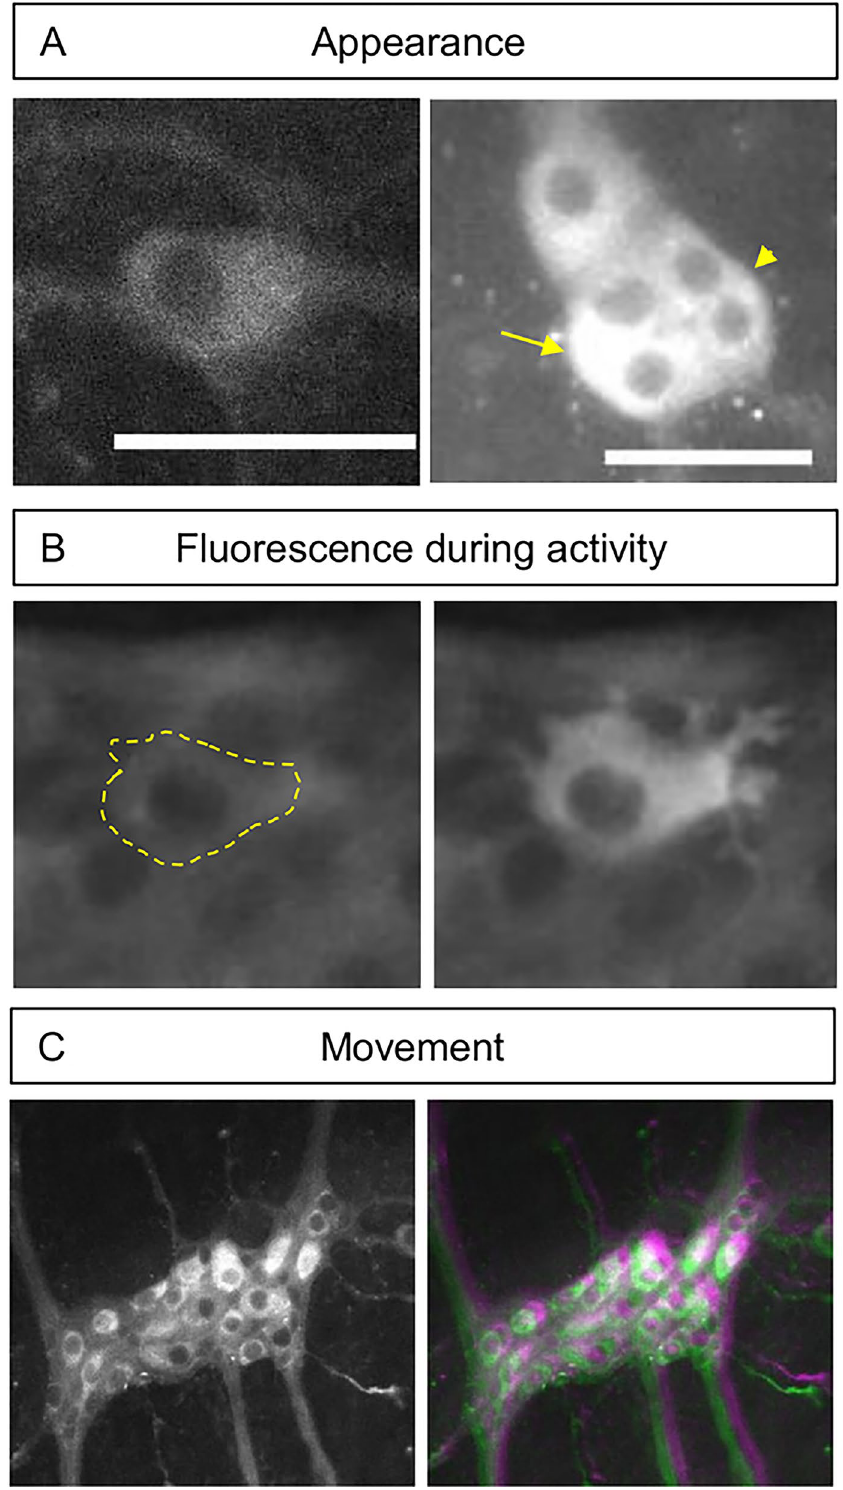
Figure 1. General features of Ca 2+ imaging in the ENS. ( A ) The appearance of an individual GCaMP expressing enteric neuron when not surrounded by other neurons (Left). The overlapping appearance of enteric neurons (arrow) and lack of clear borders (arrowhead) (Right). Scale bar represents 50 µm. ( B ) an example of the fluorescence signal increases between a neuron at rest (left, and marked with a dashed line) and during activity (right). C ) ENS ganglion (left) containing approximately 20 neurons. Imposed images of different timepoint (colorcoded in green and magenta) in an ENS Ca 2+ recording (1 s. interval between frames). The mismatch in colors indicates the amount of movement that can be present between 2